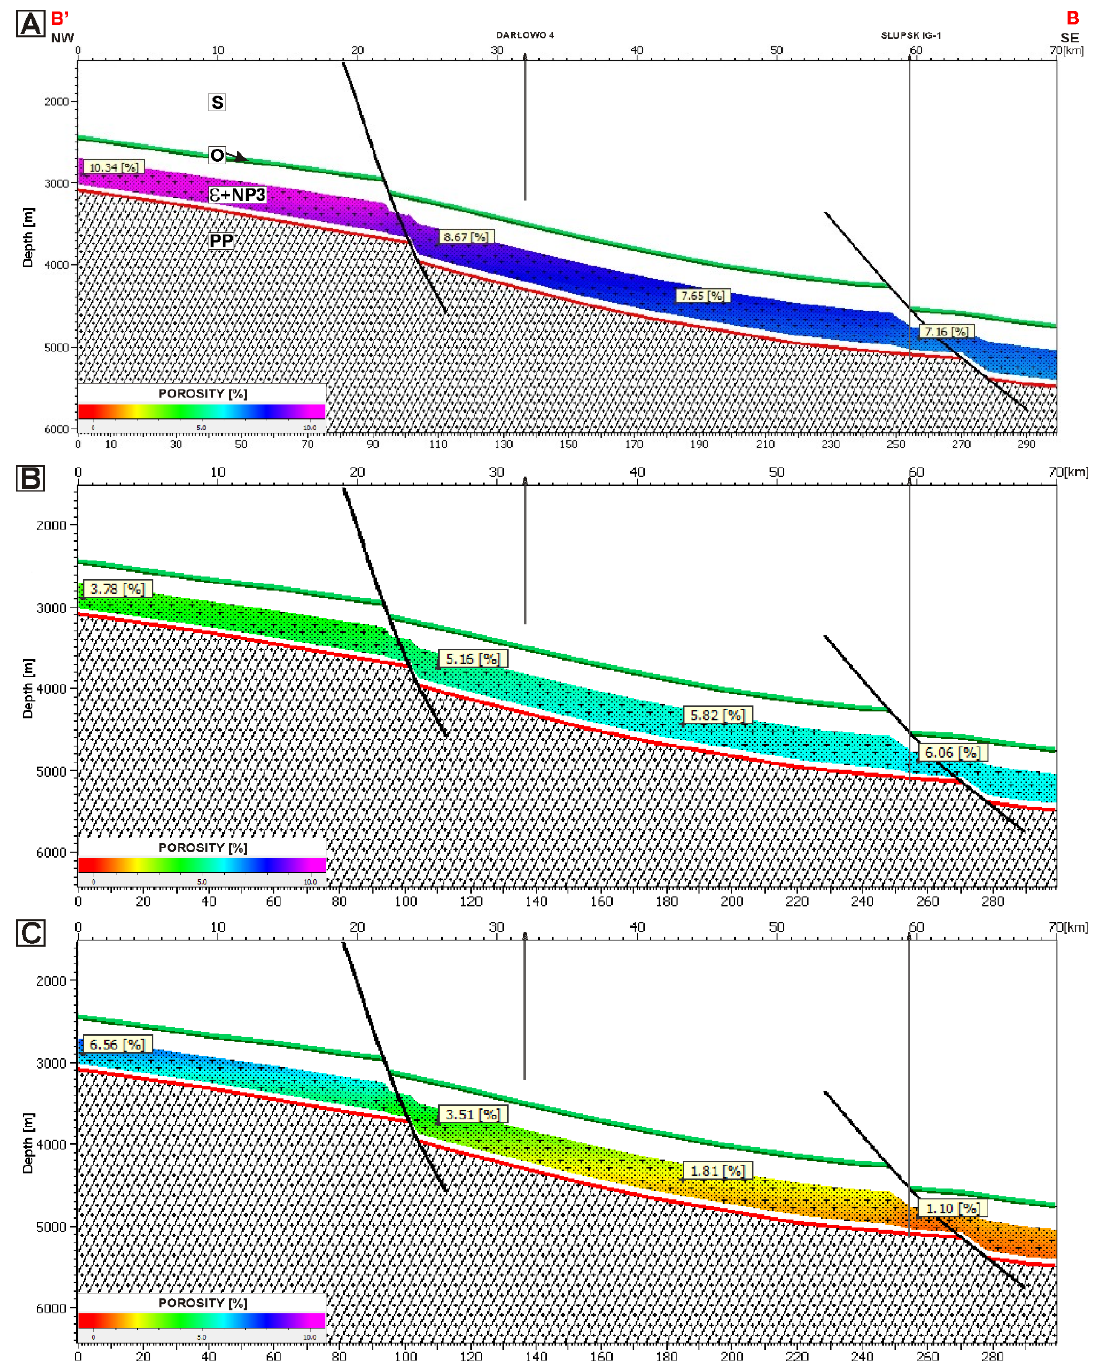
Figure 14. Modeling results of the Ediacaran-Lower Cambrian sandstones mechanical and chemical compaction processes. ( A ) Model of porosity distribution caused by mechanical compaction. ( B ) Model of lost porosity distribution caused by chemical compaction. ( C ) Porosity distribution obtained from simultaneous modelings of mechanical and chemical compactions. Stratigraphic symbols as in Figure 3.